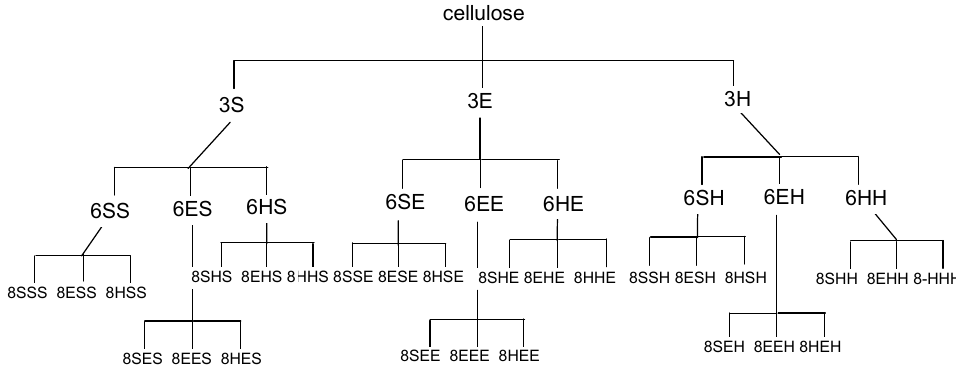
Figure 2. Diagram showing 39 precursors 3 , 6 , 8 , which after N -acylation with four carboxylic acids 4a-d yielded a 156 element library of synzymes 5 , 7 and 9 .